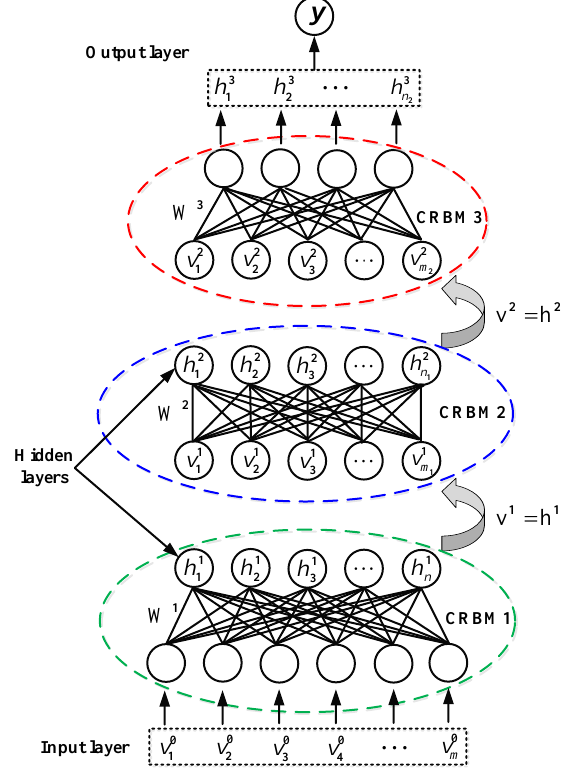
4 of 14 Figure 2. Network architectures: ( a ) an RBM and ( b ) a three-hidden-layer DBN. Generally, in the typical DBN structure, the logistic regression or Softmax regression is widely used as the last layer of the network, so the DBN is more suitable for solving classification problems [30 – 32]. However, the DBN is rarely applied to regression prob- lems. Because the original units of the RBM are binary and discrete, it is impossible to model continuous values [33]. For analog data, Chen proposed a continuous RBM (CRBM) [34]. By replacing RBM with the CRBM, the traditional classification of the DBN is im- proved and the CRBM-DBN for regression is developed. In CRBM, binary units in RBM are replaced by continuous stochastic units, and the learning rule is “Minimizing Contras- tive Divergence” (MCD) [35]. The continuous stochastic unit is as follows: () 0 , 1 jjijij i s